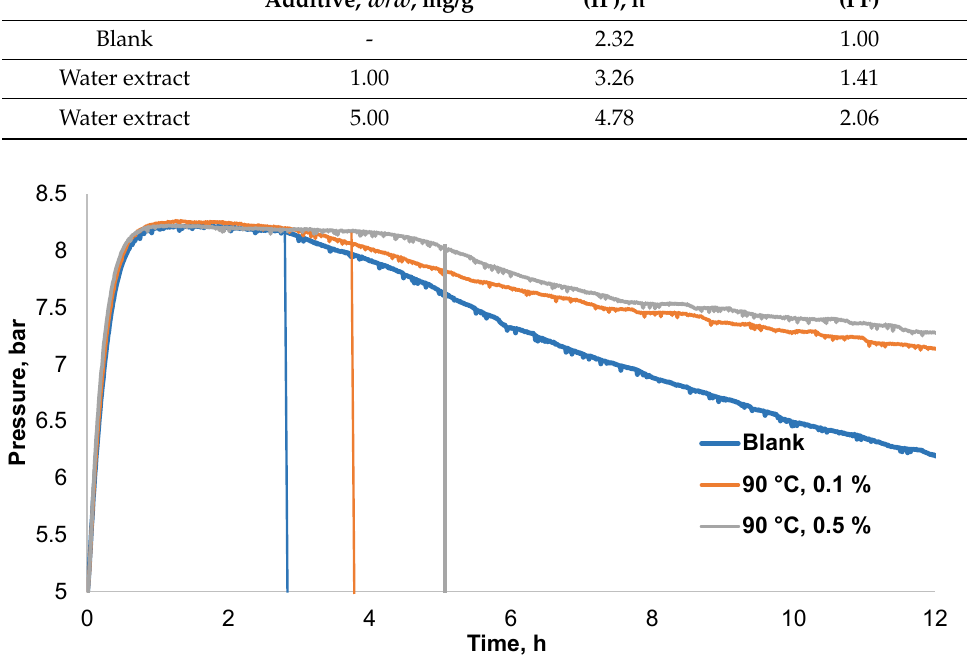
Figure 9. Effect of black alder bark deionized water extract oxidative stability of commercial mayonnaise at 120 °C demonstrated a higher PF than commercial mayonnaise without additive (blank).